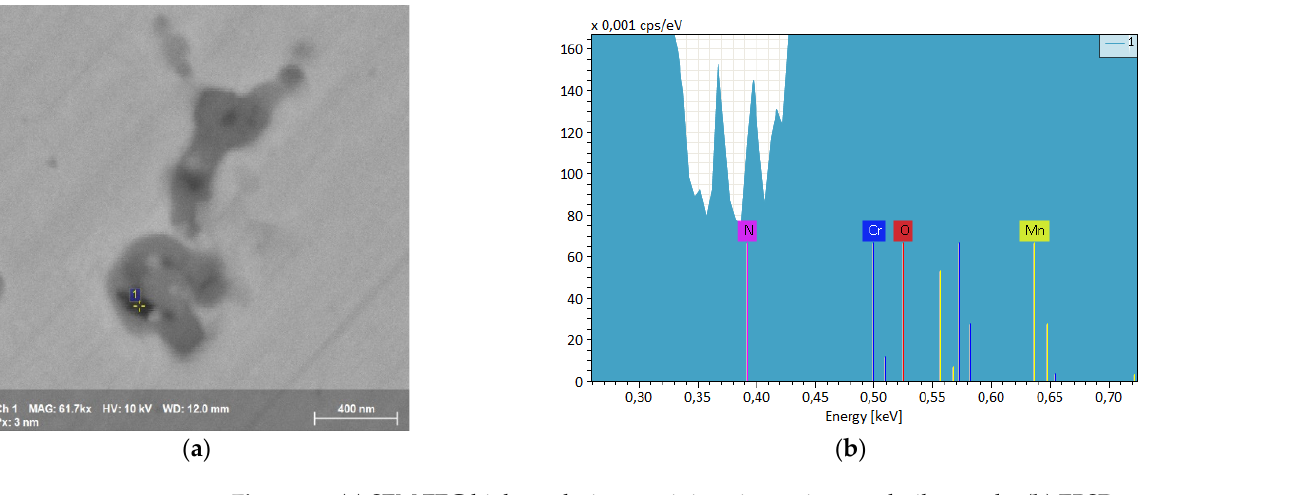
Figure 10. ( a ) SEM FEG high resolution precipitate image in an as-built sample. ( b ) EBSD spectrum of the black area of ( a ) containing a fine nitride precipitate.